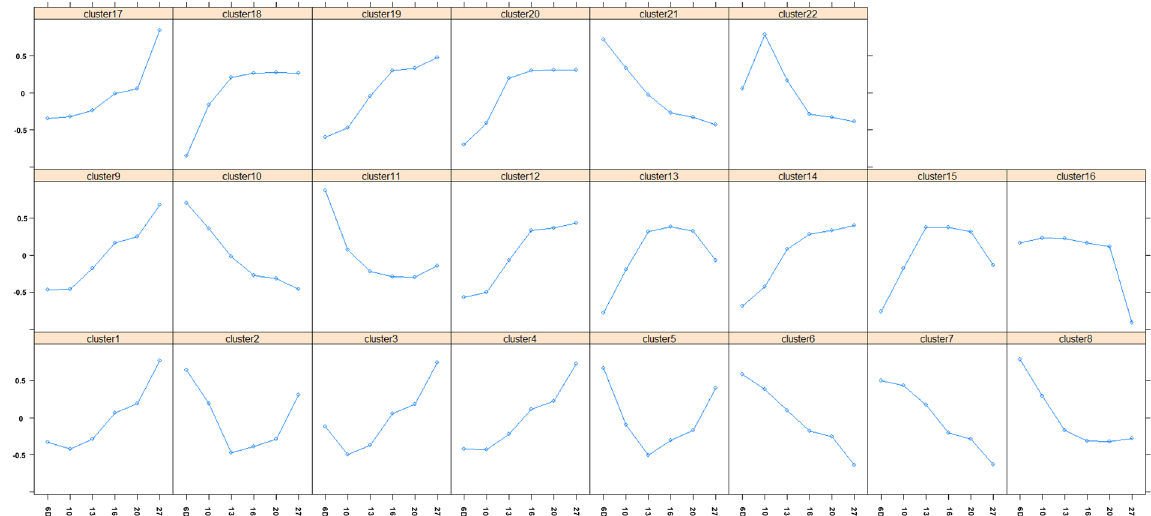
Figure 7. Clustering of the expression profiles of 2110 differentially expressed probes at six different time- points during M . truncatula MC development. Clustering was performed using k-means statistics and 22 clusters were chosen for further analysis of transcriptional patterns. The number of genes in each cluster is listed in parentheses. The X-axis indicates the number of days post pollination (DPP). The Y-axis indicates the LOG 2 - transformed fold-change of stage-specific intensity relative to the baseline intensity of each